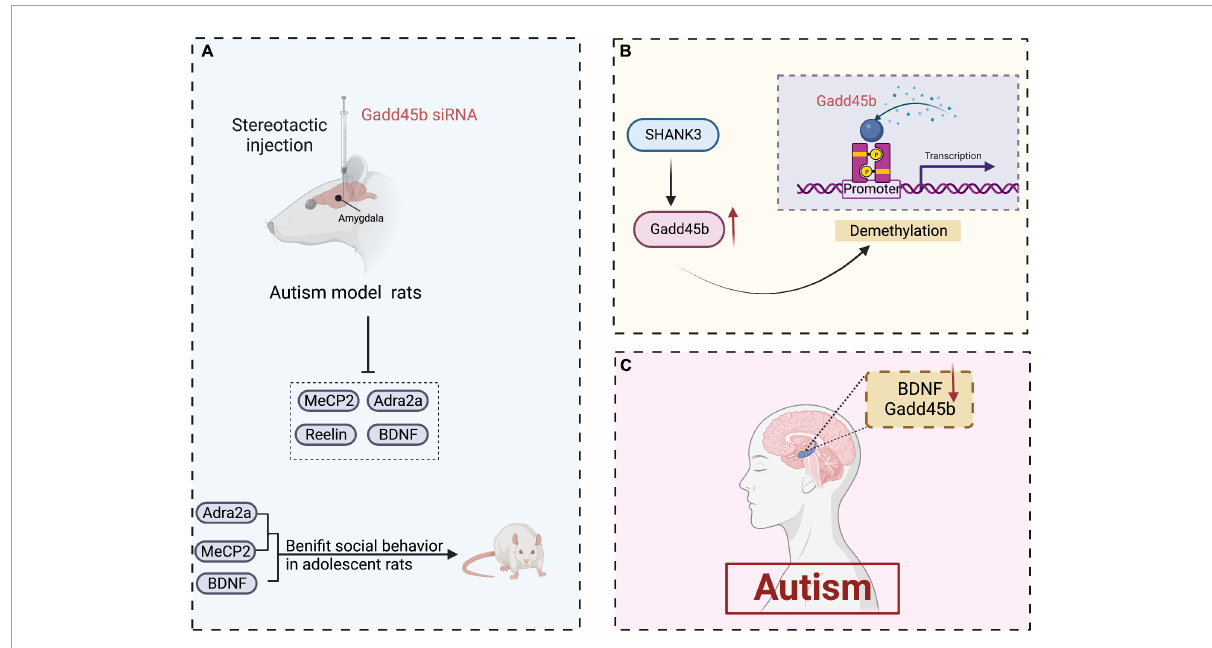
FIGURE4 Roles of growth arrest and DNA damage-inducible beta (Gadd45b) in autism. (A) Stereotactic injection of gadd45b siRNA decreases the production of MeCP2, BDNF, Adra2a, and Reelin in autistic rats, where MeCP2, BDNF, and Adra2a contribute to adolescent rats’ social competence. (B) SHANK3 enhances gadd45b expression, which may be related to gadd45b demethylation. (C) Decreased Gadd45b and BDNF expression in the brain of patients with autism (Figure was created with